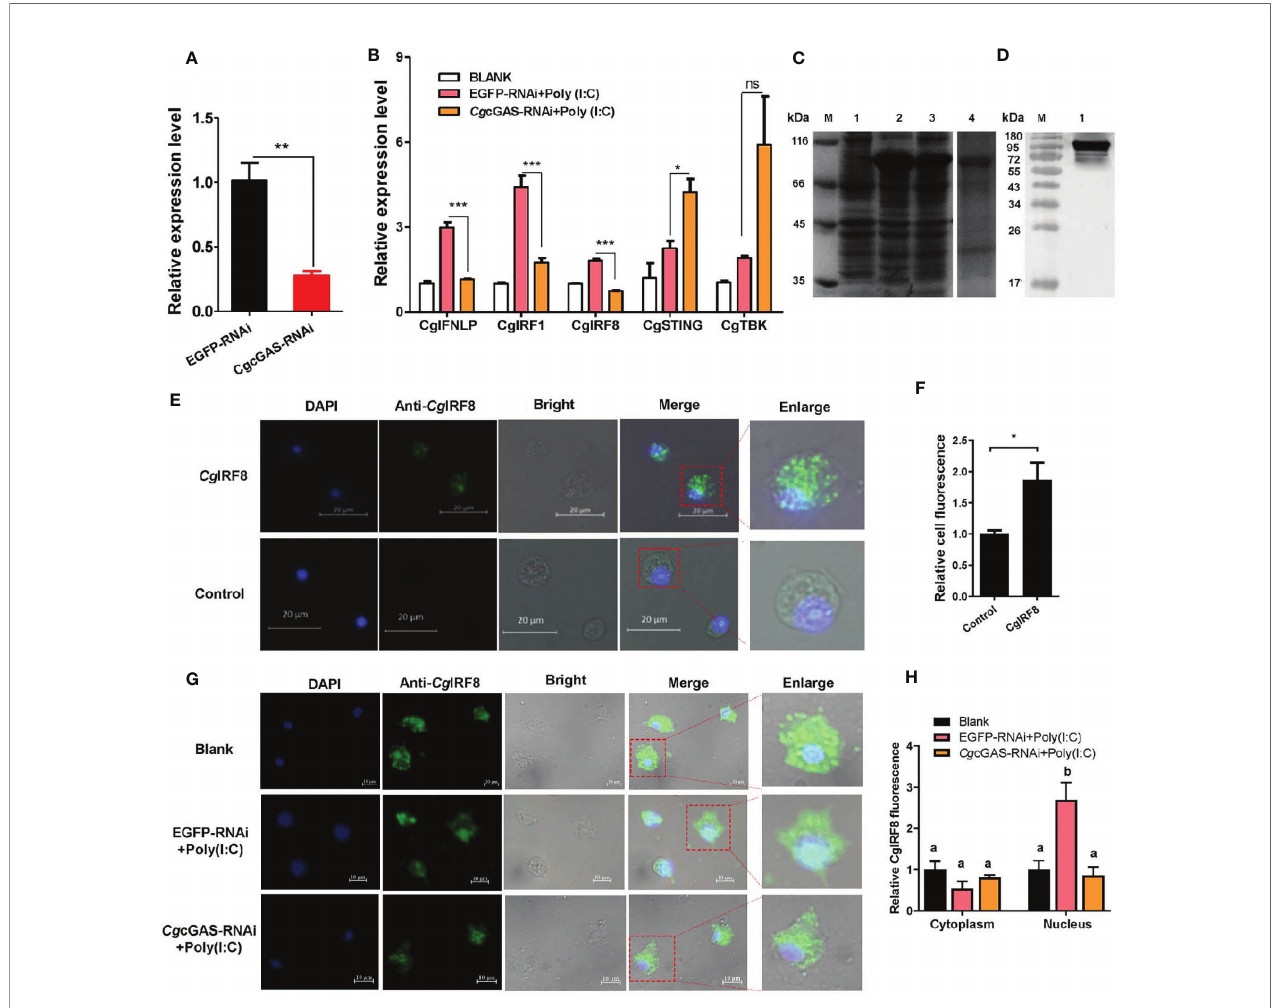
FIGURE 3 | Regulation of Cg cGAS on the expression of Cg IFNLP and nuclear translocation of Cg IRF-8. (A) The ef fi ciency of Cg cGAS – RNAi in hemocytes. EGFP – RNAi was used as control. (B) The mRNA expressions of Cg IFNLP, Cg IRF-1, Cg IRF-8, Cg STING, and Cg TBK1 in Cg cGAS – RNAi oysters after Poly (I:C) stimulation. (C) The recombination protein of Cg IRF-8. Lane M: standard protein molecular weight marker; Lane 1: negative control (without induction); Lane 2: induced r Cg IRF- 8; Lane 3: Supernatant of lysate; Lane 4: puri fi ed r Cg cGAS. (D) Lane 1: speci fi city of polyclonal antibody for Cg IRF-8 examined by Western blot. (E) The subcellular localization of Cg IRF-8 (negative serum as control) in hemocytes and (F) the statistical analysis of relative fl uorescence intensity of Cg IRF-8 using ImageJ. (G) The subcellular localization of Cg IRF-8 in Cg cGAS – RNAi hemocytes after Poly (I:C) stimulation and (H) the statistical analysis of fl uorescence intensity using ImageJ. Nucleus staining with DAPI is shown in blue signal; anti- Cg IRF-8 conjugated to Alexa- fl uor 488 is shown in green signal. Vertical bars represent the mean ± SEM. (N = 3). * p < 0.05; ** p < 0.01; *** p < 0.001; ns, not signi fi cant. The different letters show the existence signi fi cant differences comparing with other groups ( p <